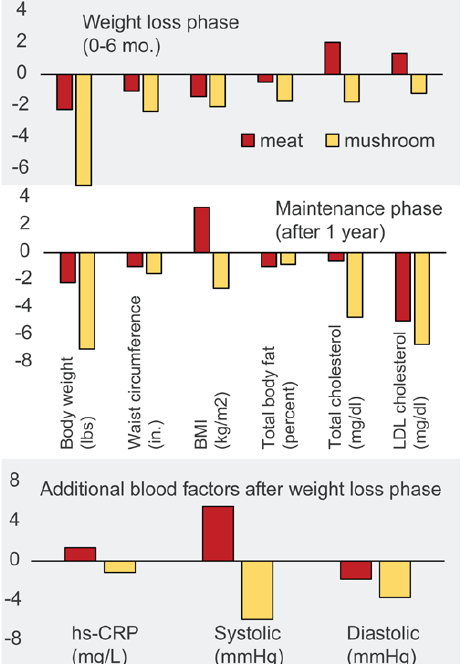
Figure 8. Weight loss diet substituting white button mushrooms for beef with no change in caloric content. Based on data from Poddar, et al. [11].